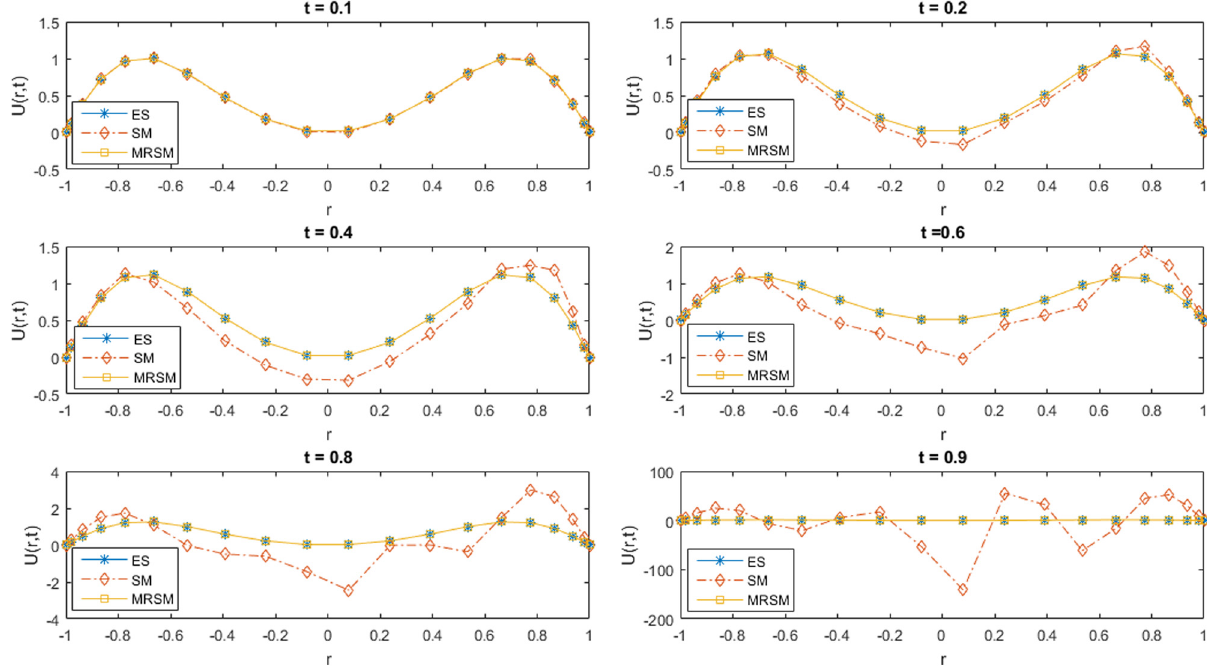
Figure 2: ES and behaviors of SM and MRSM for Example 4.1 for r −1, 1 [ ] ∈ and M 20 = and various times t 0.1, 0.2, 0.4, 0.6, 0.8 = , and 0.9 −1 = × . with N 20 = , μ 1 10 1